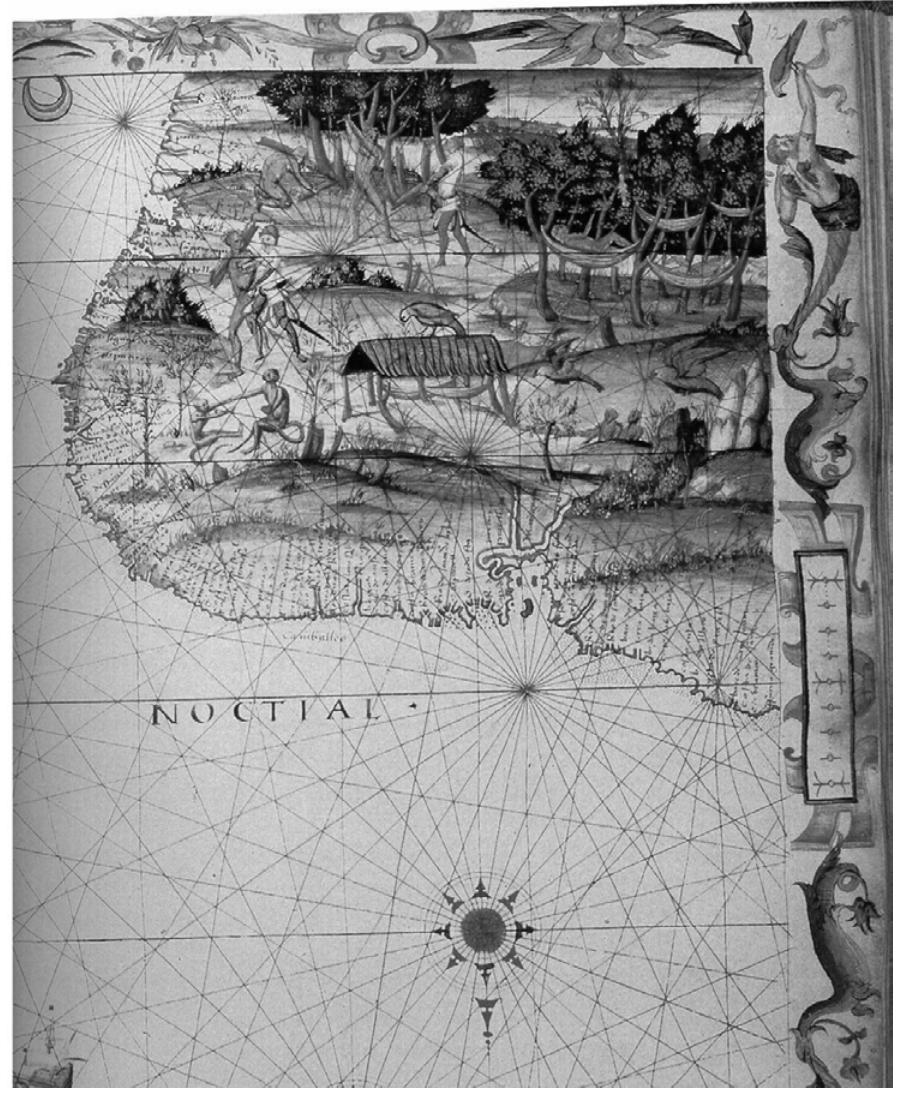
Fig. 5 – Detail of Carta do Nordeste do Brasil e África Ocidental , atlas Portuguese-French, 1538 (Couto 1999).